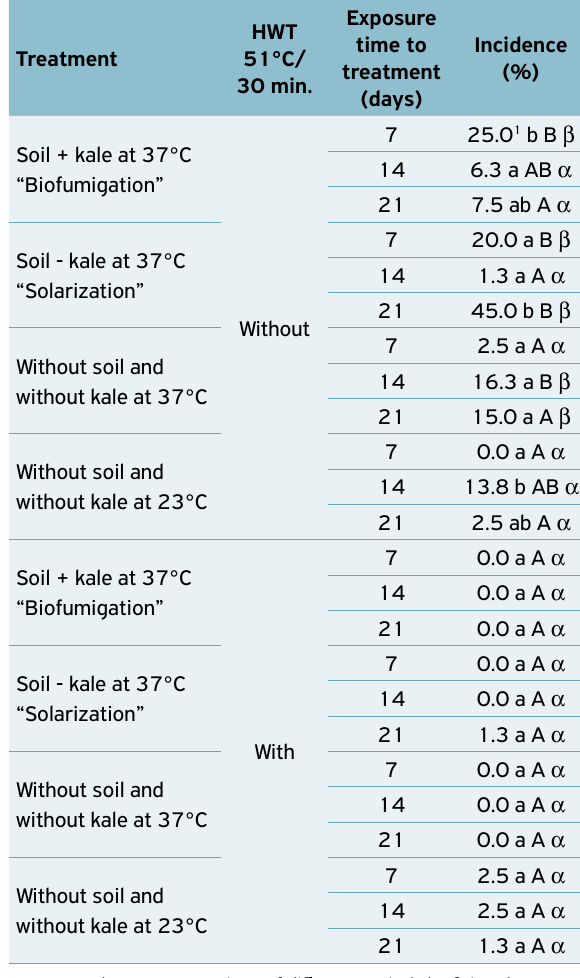
Table 4. Percentage of incidence of Phaeomoniella chlamydospora in samples of the vascular system of the basal part of the rootstock IAC 766, submitted to different treatments for different periods, with and without added hot-water treatment